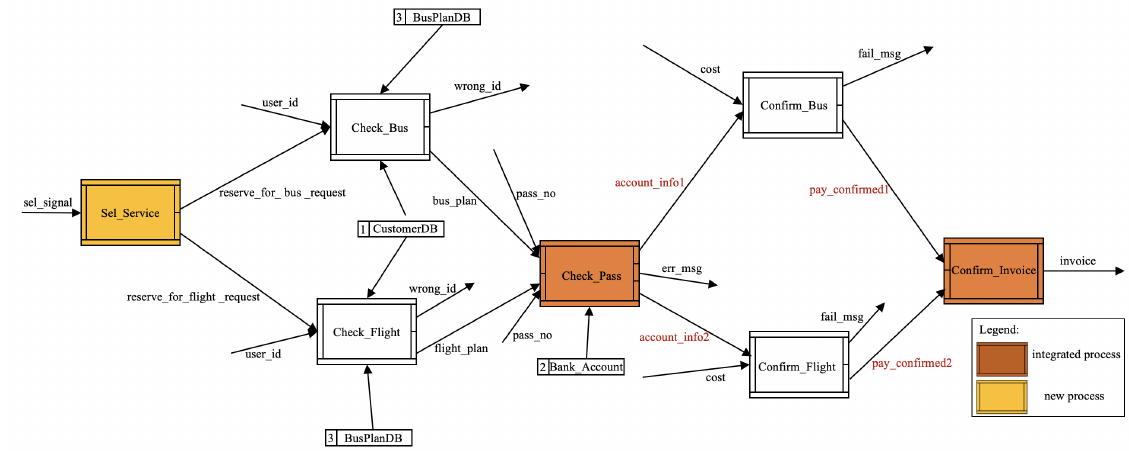
Figure 12. CDFD diagram of integrating